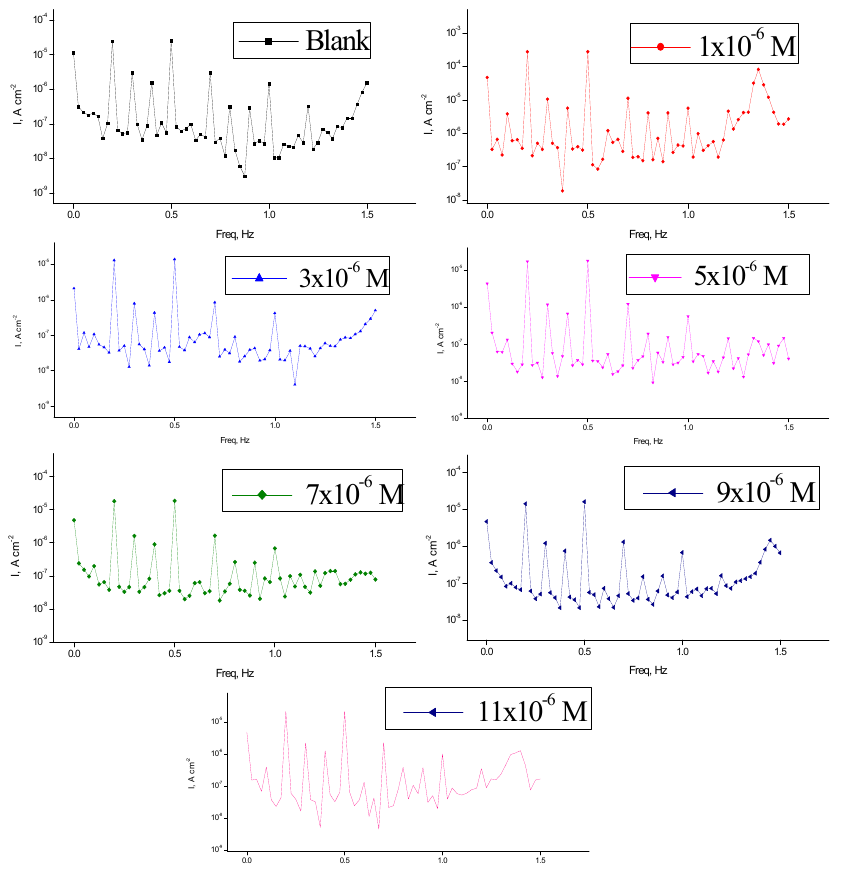
Figure 4. EFM bends for the corrosion of Q235 steel in corrosive environments attendance and lack of unlike dose of spiropyrazoles (1). Table 4. EFM parameters for Q235 steel in corrosive environments attendance and lack of unlike dose of spiropyrazoles derivatives at 25 ± 1 °C. Cpd. No.